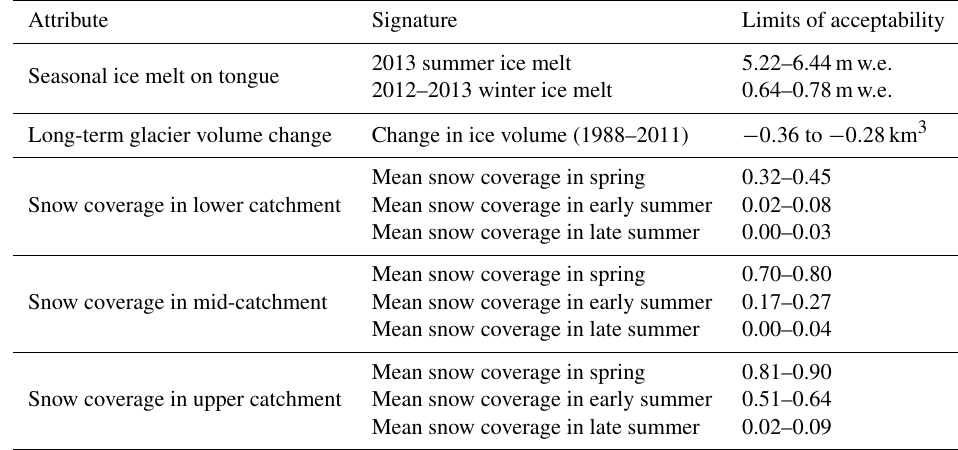
Table B1. Summary of 12 ice melt and snow coverage signatures used to calibrate the GHM with their limits of acceptability. Note that snow coverage is expressed as a proportion of the glacier-free basin